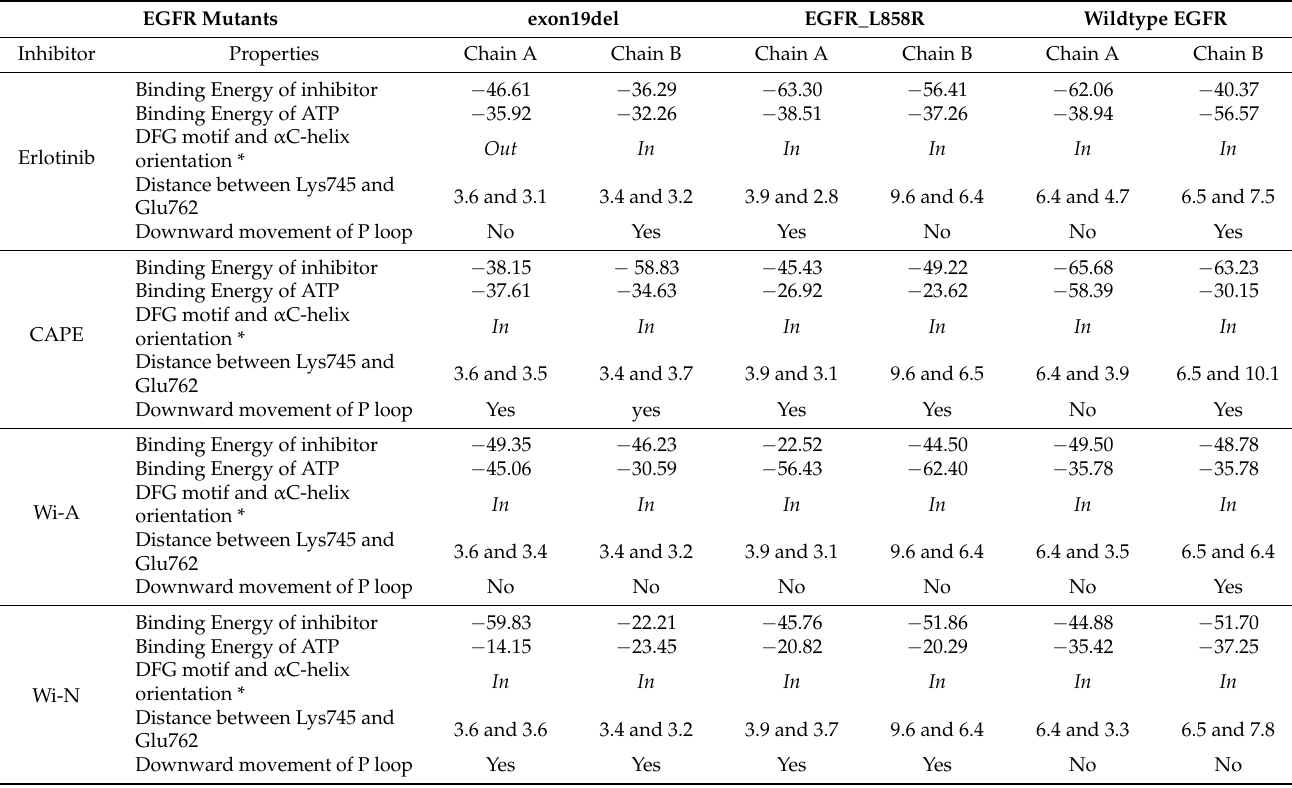
Table 2. Activity of compounds on different structural properties of EGFR and its mutants as ATP competitive inhibitors. The binding free energy is given in Kcal/mol and the distances are in